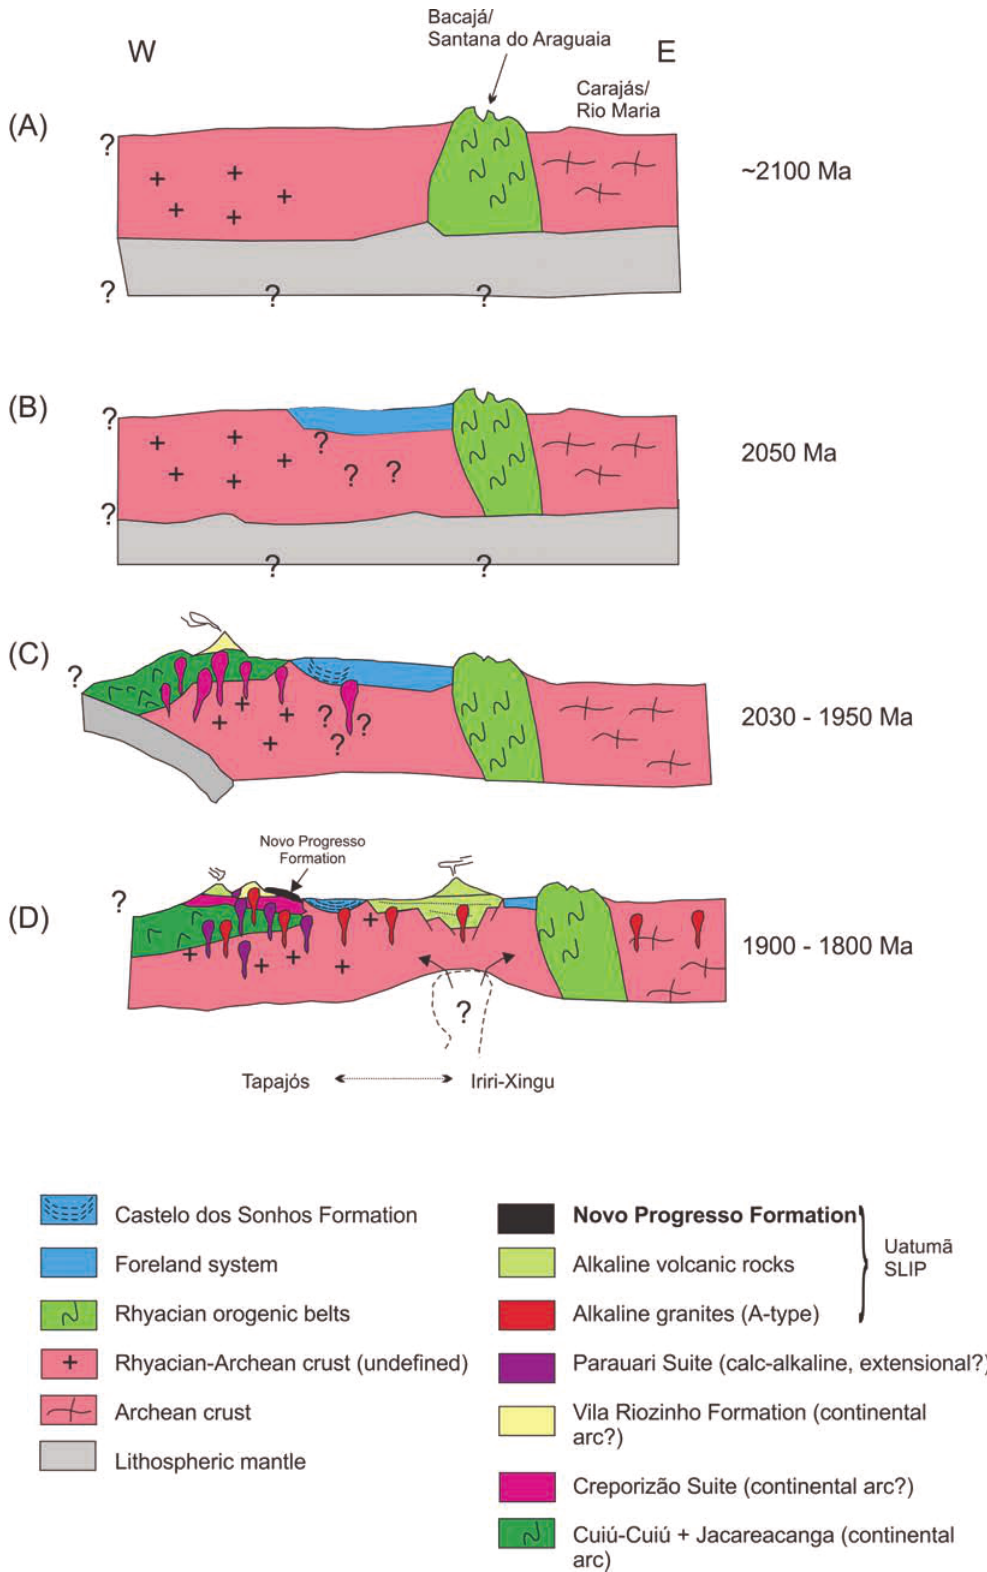
Figure 9 - Schematic (not to scale) W–E crustal sections of the SE Amazonian Craton depicting the proposed scenario for the geological evolution of the Novo Progresso Formation. Geological units are described in Figure 2 and the source areas (tectonic domains) are those presented in Figures 1 and 8. (A) Formation of Rhyacian orogenic belts. (B) Development of Rhyacian foreland systems over an Archean - Paleoproterozoic block. (C) Orogenic phase in the Tapajós Gold Province. (D) Extensional phase with intrusion of early granitoids followed by rifting and development of the Uatumã Silicic Large Igneous Province and deposition of the Novo Progresso Formation (adapted from Klein et al. 2107). The Castelo dos Sonhos Formation was interpreted (Klein et al. 2017) as part of the foreland system, which remained in margin of the Tapajós domain after the Uatumã